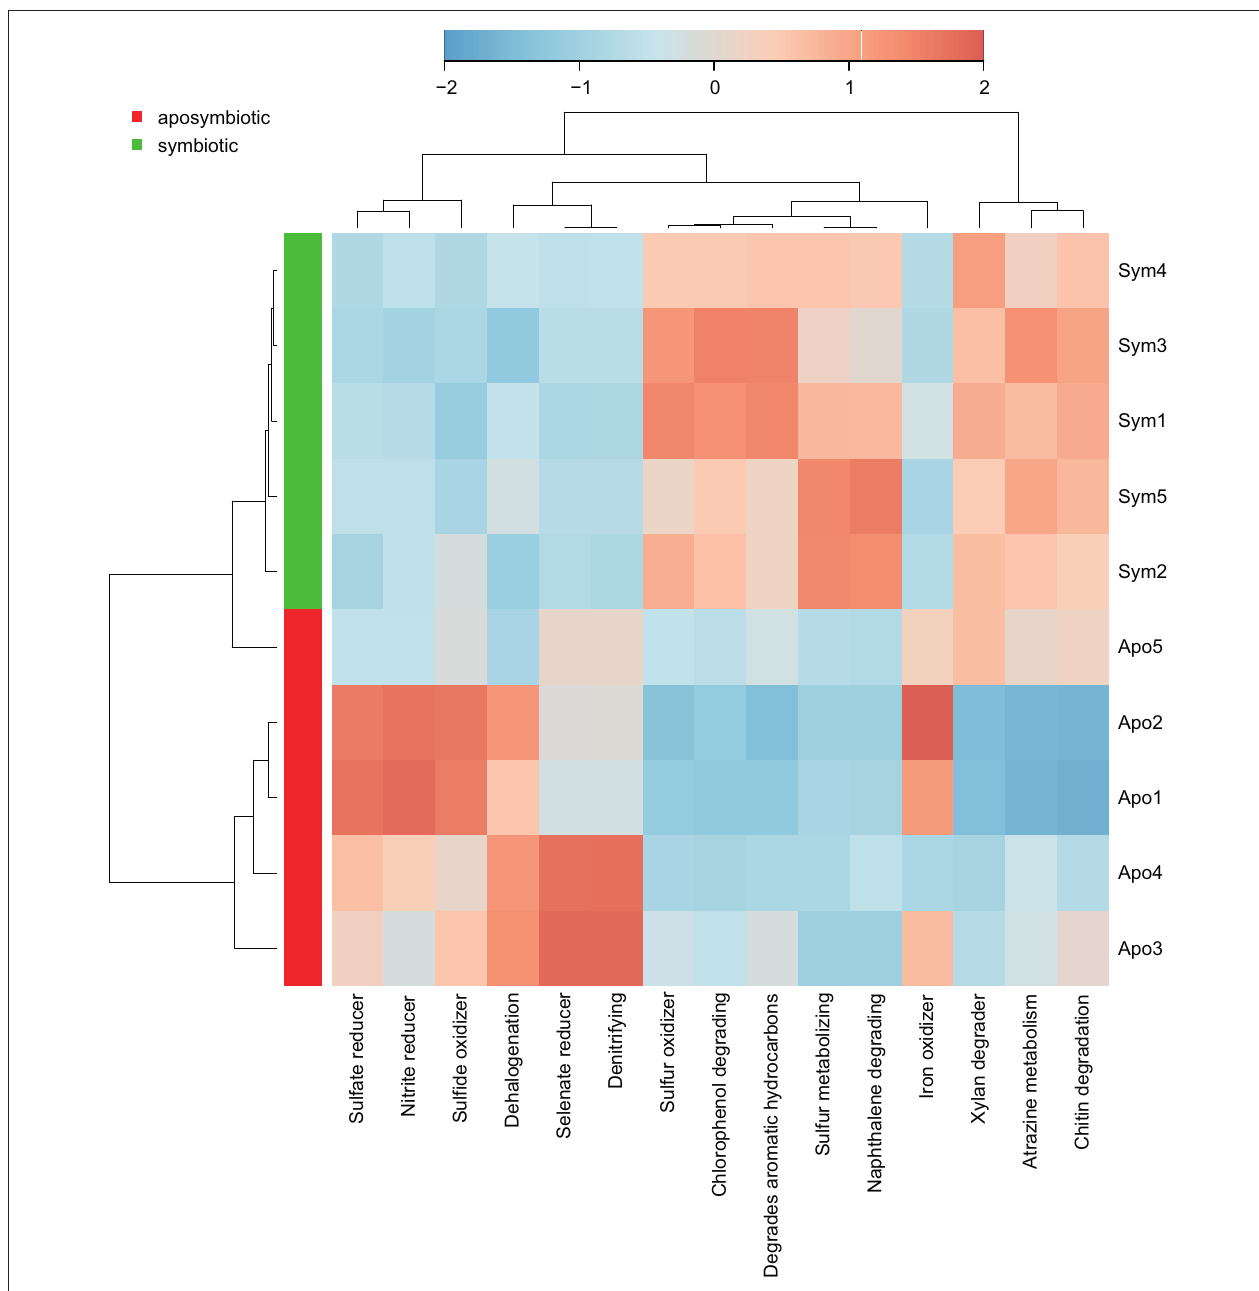
FIGURE 3 | Taxonomy-based functional profiling of bacterial communities. Heatmap displaying putative functional differences based on the bacterial community composition of aposymbiotic and symbiotic Aiptasia . Changes are displayed on a relative scale with enrichment in red and depletion in blue. Sym, symbiotic Aiptasia ; Apo, aposymbiotic Aiptasia